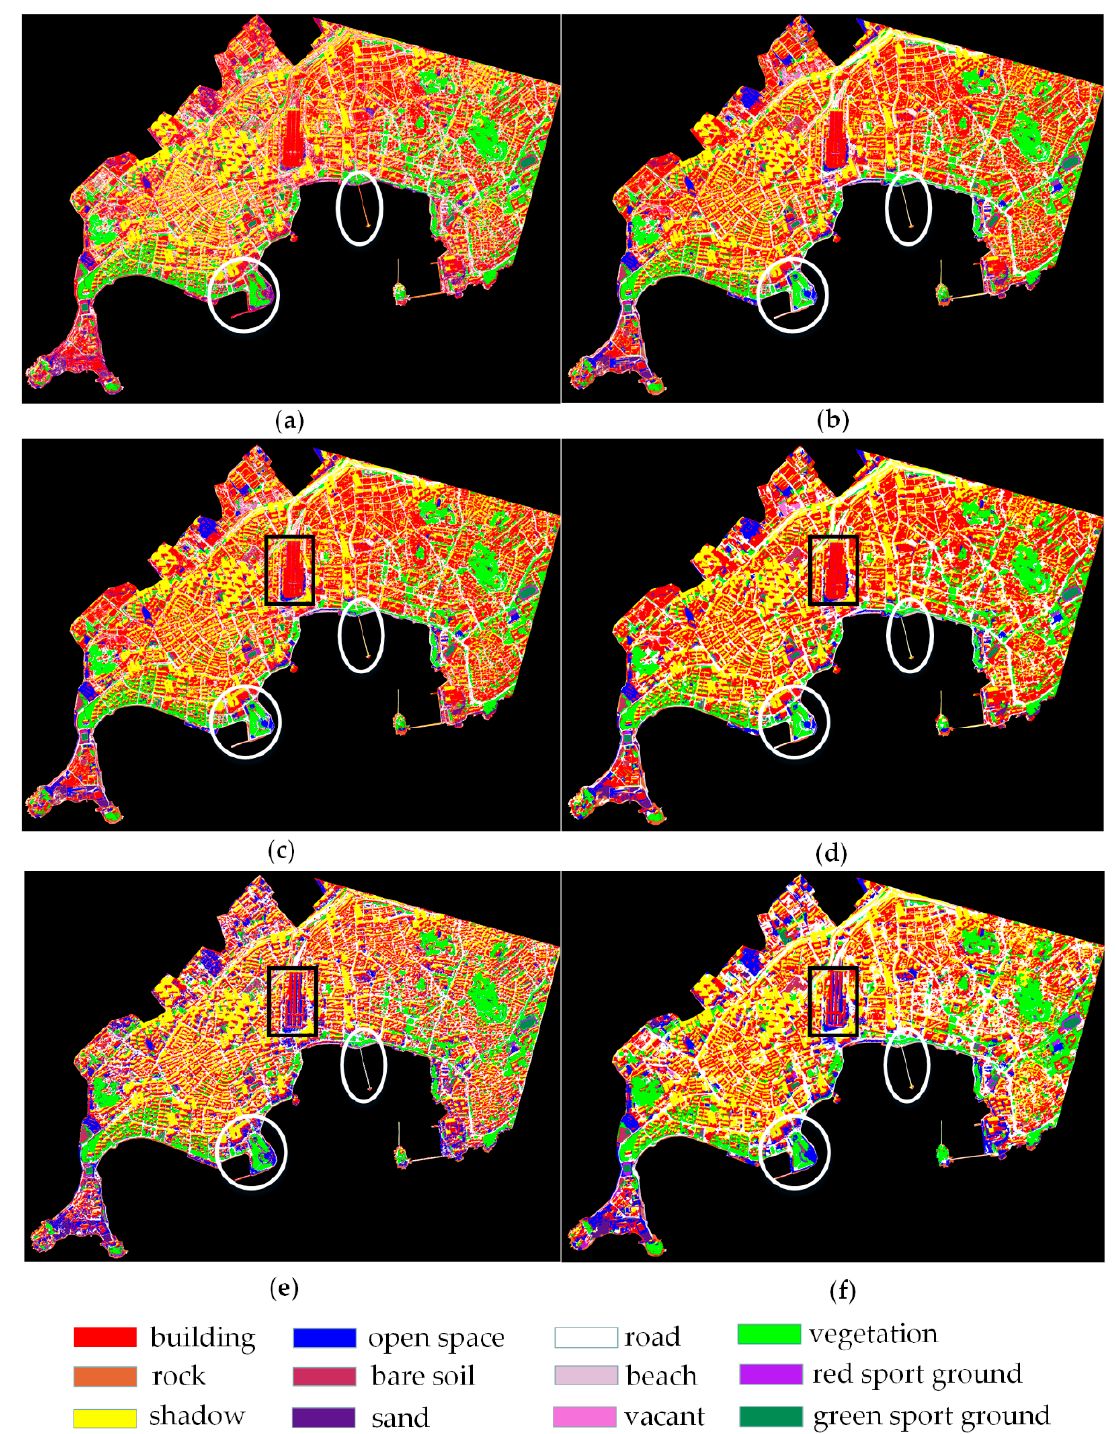
Figure 4. Classification results of the six methods. ( a ) Raw; ( b ) SS; ( c ) OSS; ( d ) OSS-MSSC; ( e ) VGG; ( f ) VGG-MSS.